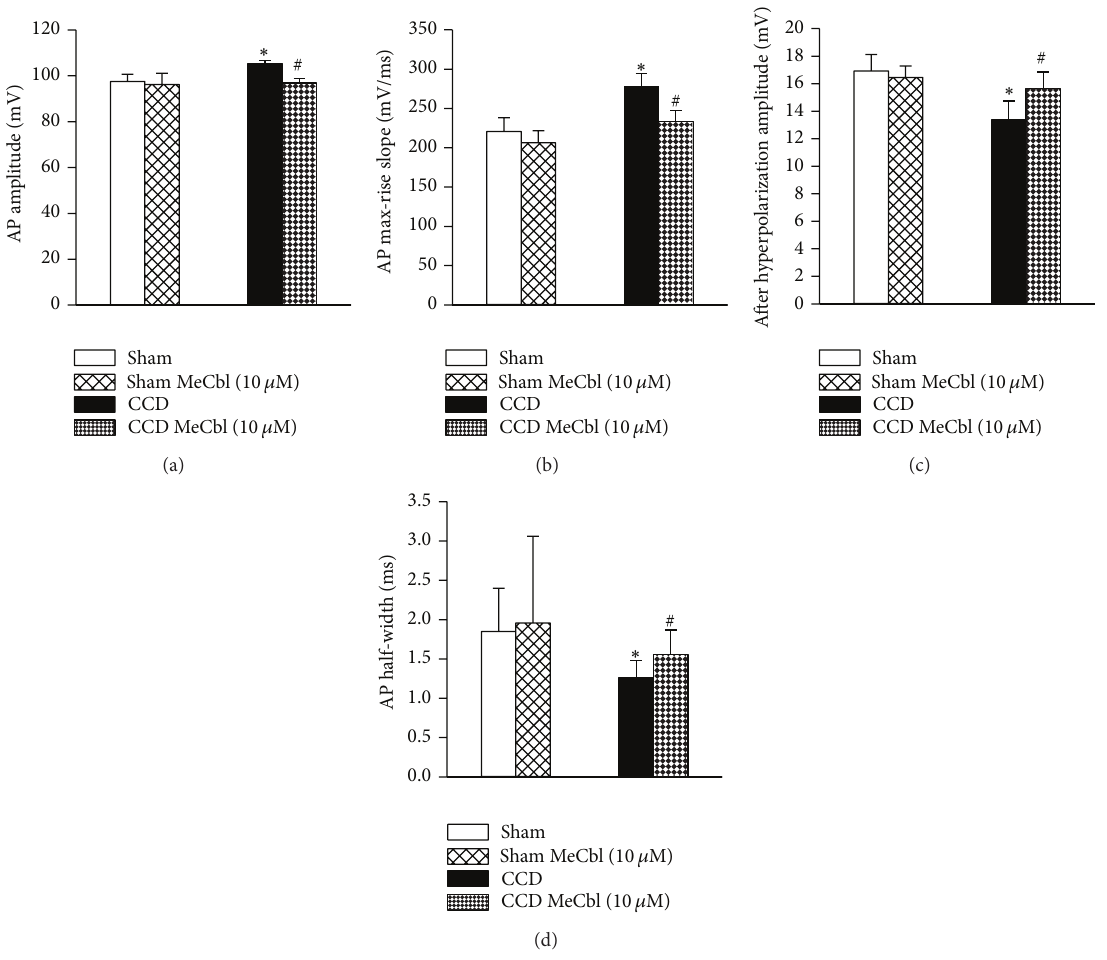
Figure 4: Effects of MeCbl on active membrane properties of medium-sized DRG neurons. Effects of MeCbl on active membrane properties of medium-sized DRG neurons. (a) AP amplitude; (b) AP max-rise slope; (c) AHP amplitude; (d) AP half-width. # 𝑃 < 0.05 , significant differences in active membrane properties of medium-sized DRG neurons compared to those in the absence of MeCbl group; ∗ 𝑃 < 0.05 , compared with those of sham